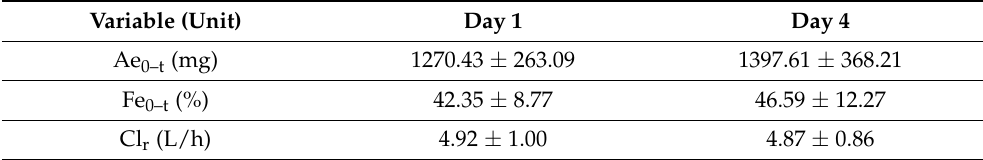
Table 3. Total amount of fosfomycin excreted in urine and renal clearance (Cl r ) calculated on Days 1 and 4 after one and two consecutive doses of fosfomycin trometamol (N = 24). Variable